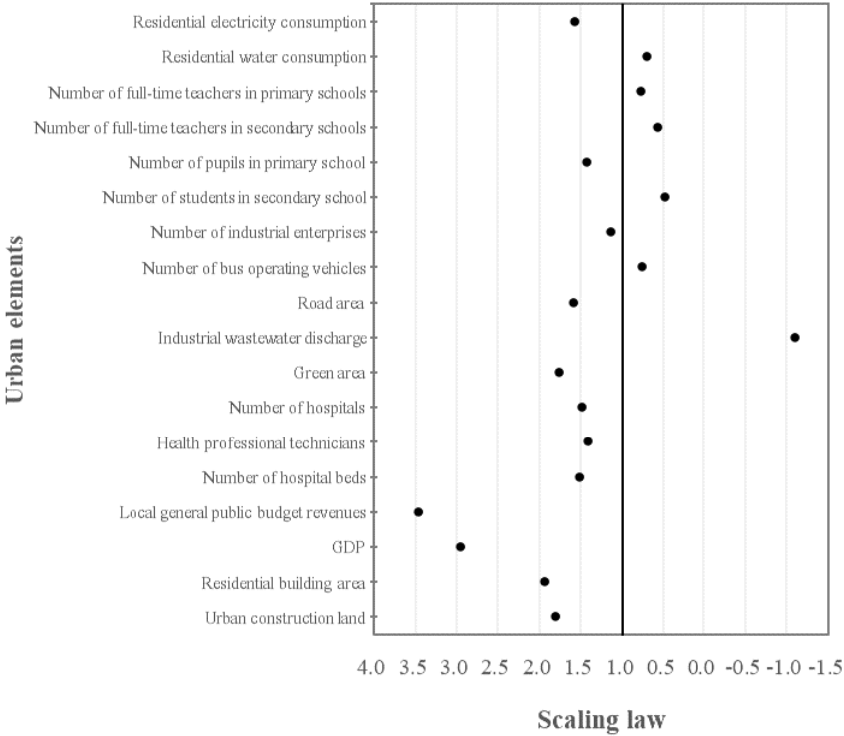
Figure 3. Temporal scaling laws of urban indicators in Wuhan.